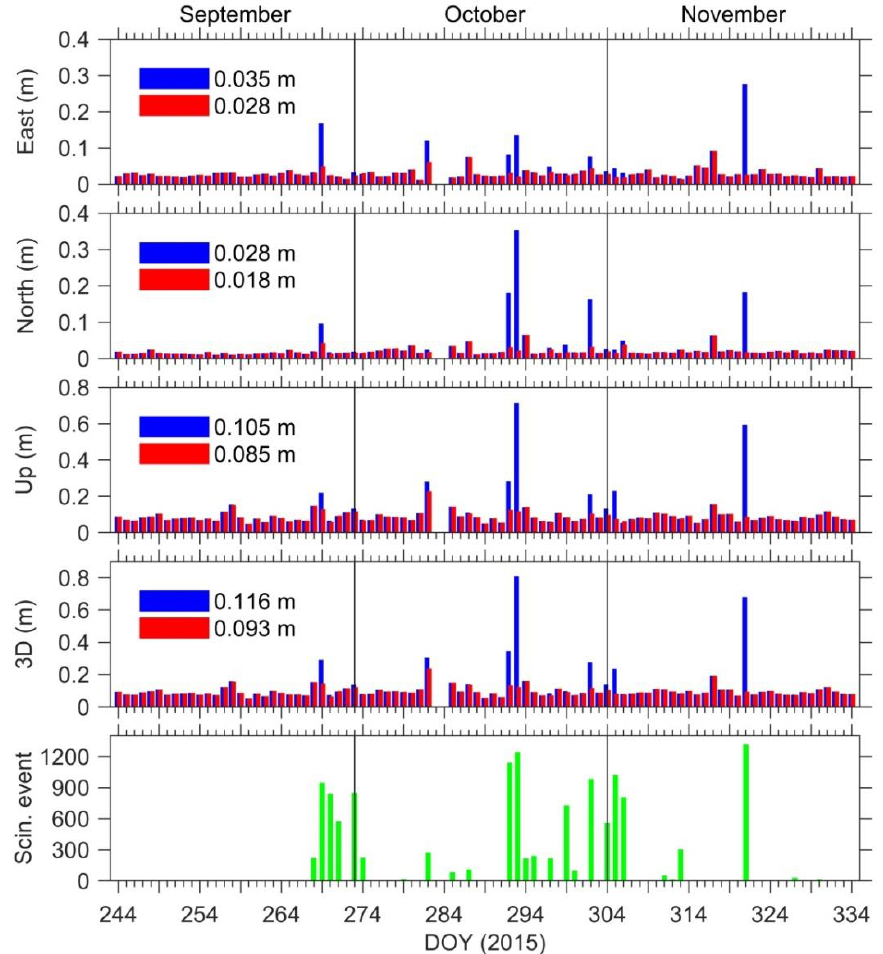
Figure 12. RMS statistics of standard BDS PPP (blue) and mitigated PPP (red) in the east, north, up, and 3D directions under different ionospheric scintillation (green) from 1 September to 30 November 2015. The corresponding mean RMS values are shown in the upper left corner.